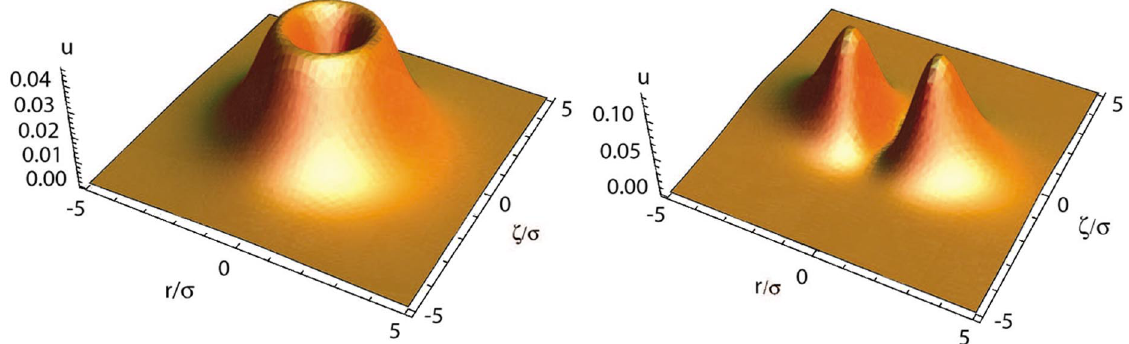
FIG. 1. (Color) Electromagnetic energy density u in units Q 2 = 8 (cid:3)(cid:4) 4 for a spherical Gaussian bunch with (a) (cid:1) (cid:4) 1 and (b) (cid:1) (cid:4) 2 . Note the difference in the vertical scales.